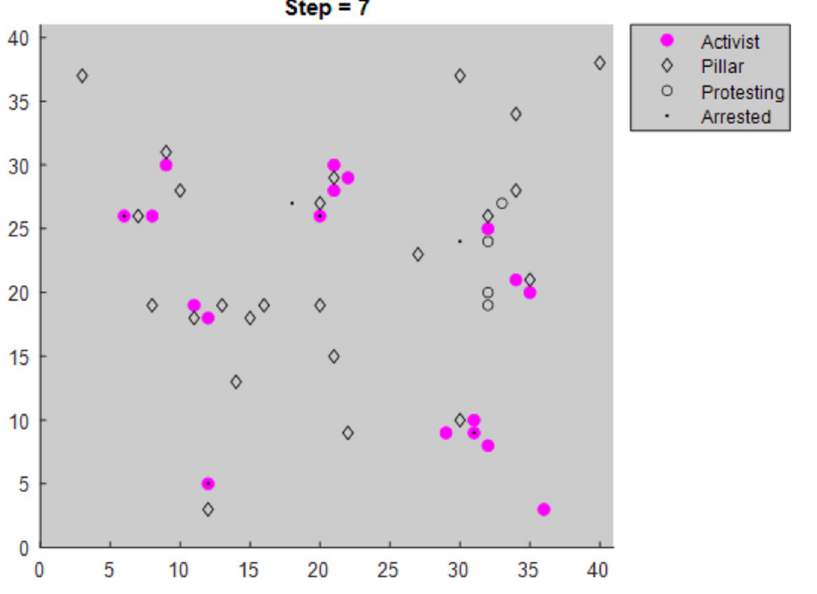
Fig 6. Activists using Pillar Prox strategy = 1 (Moving to the nearest